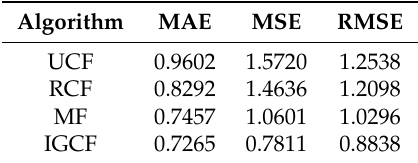
Figure 20. RMSE. Table 2. Comparison of algorithm results when NeighborSize =